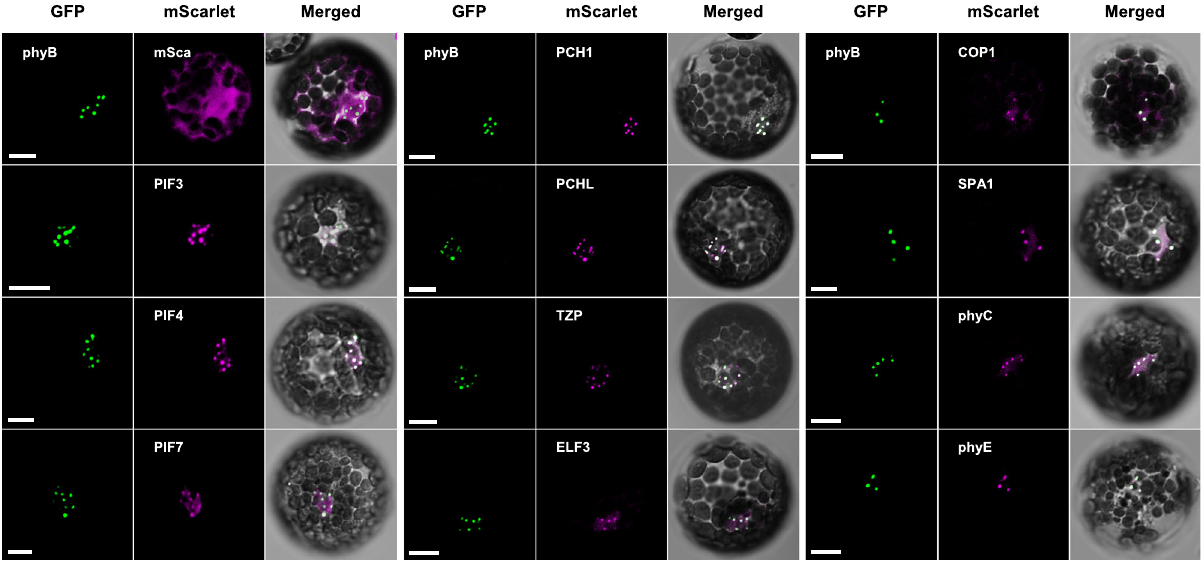
showed diffuse mSca signals. The transformed protoplasts were cultured for 16h under continuous white light (10 μ mol/m 2 /s) before observation. Scale bars=10 μ m. The representative images were shown in observation of at least 30 indepen- the co-localization are in Supplementary Fig. 5. Source data are provided as a Source Data fi